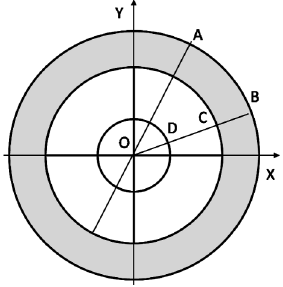
FIG. 3. Cross section of the vacuum chamber downstream of the CS. R ¼ OA is the chamber radius; r ¼ OC is the ‘‘beam stay clear’’ radius; a clearance ring of width (cid:1) ¼ BC prevents particles from hitting the vacuum chamber surface. The colli- mator half aperture footprint g ¼ OD is also projected on the ð x; y Þ plane (not to scale).